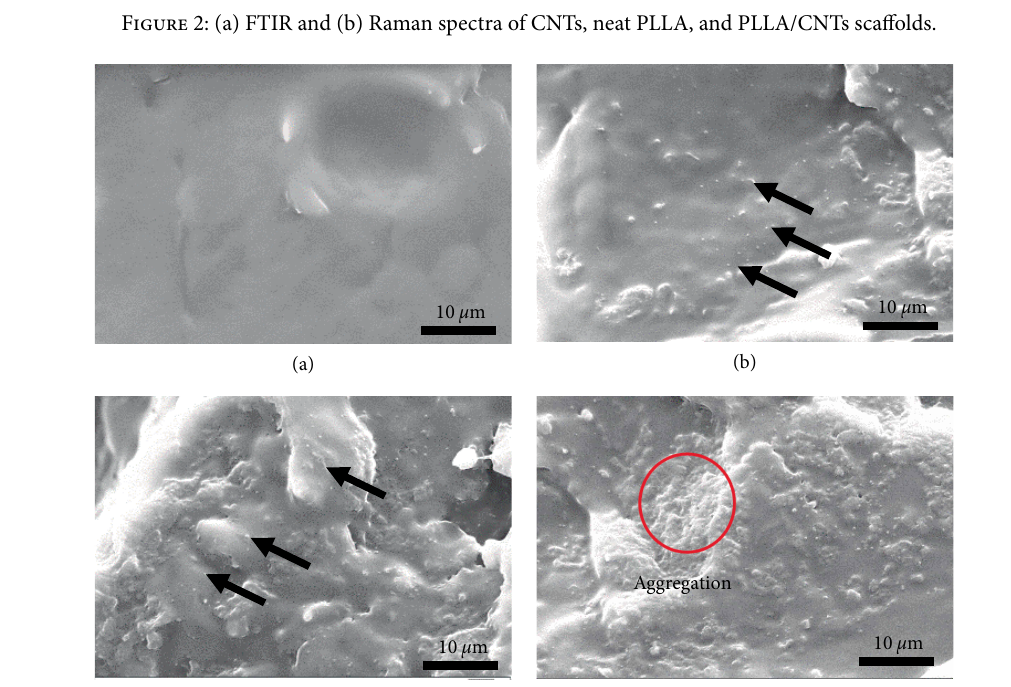
Figure 3: SEM showing the fracture surface of (a) PLLA, (b) PLLA/0.25CNTs, (c) PLLA/0.5CNTs, and (d) PLLA/1.0CNTs scaffolds.